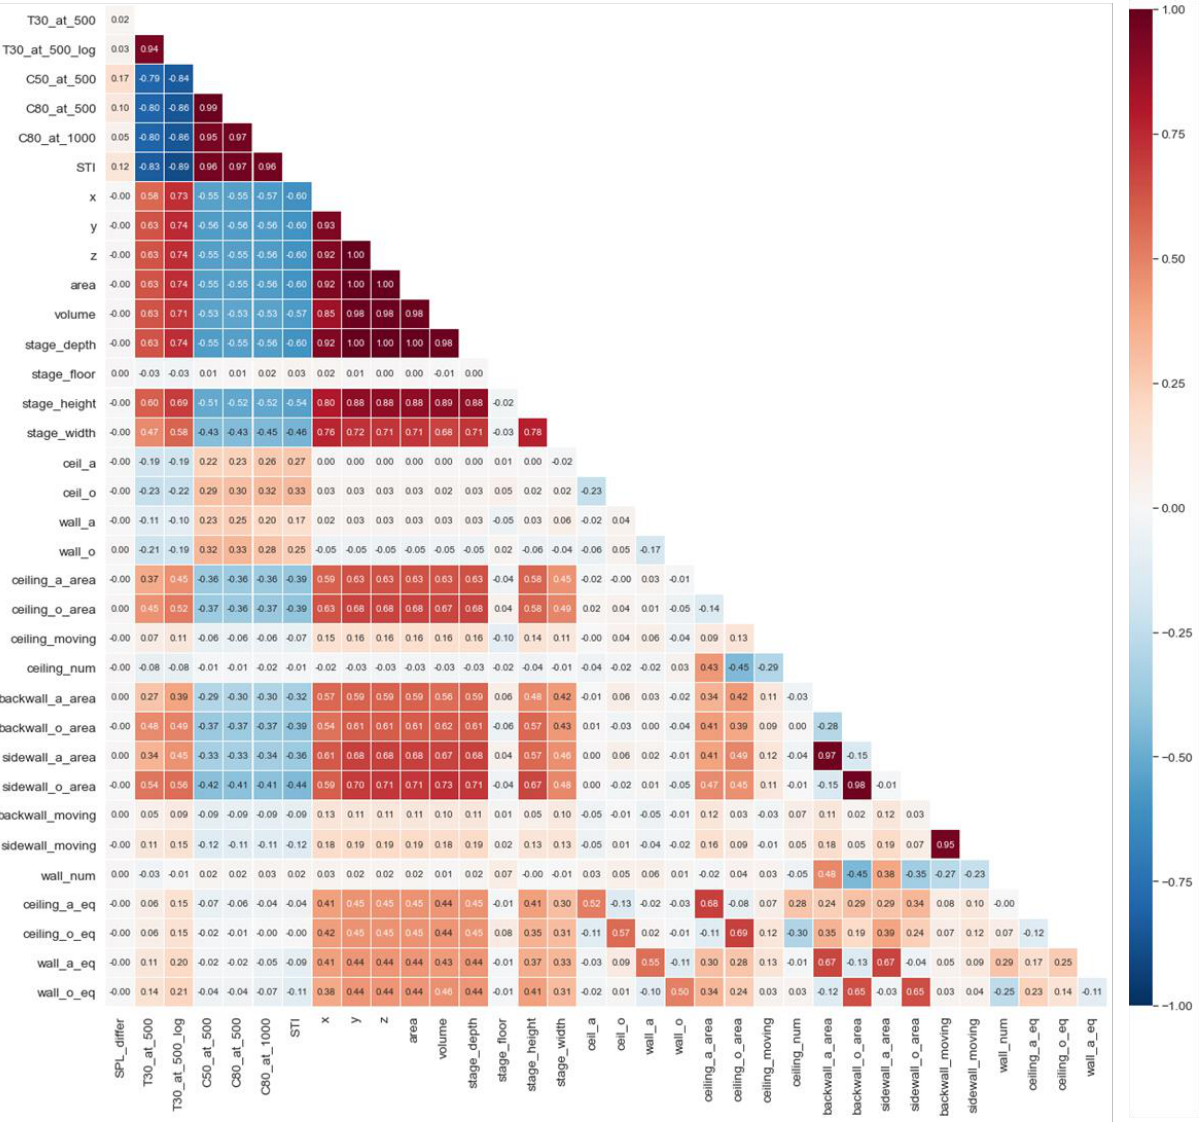
Figure 17. Correlation matrix of dataset.